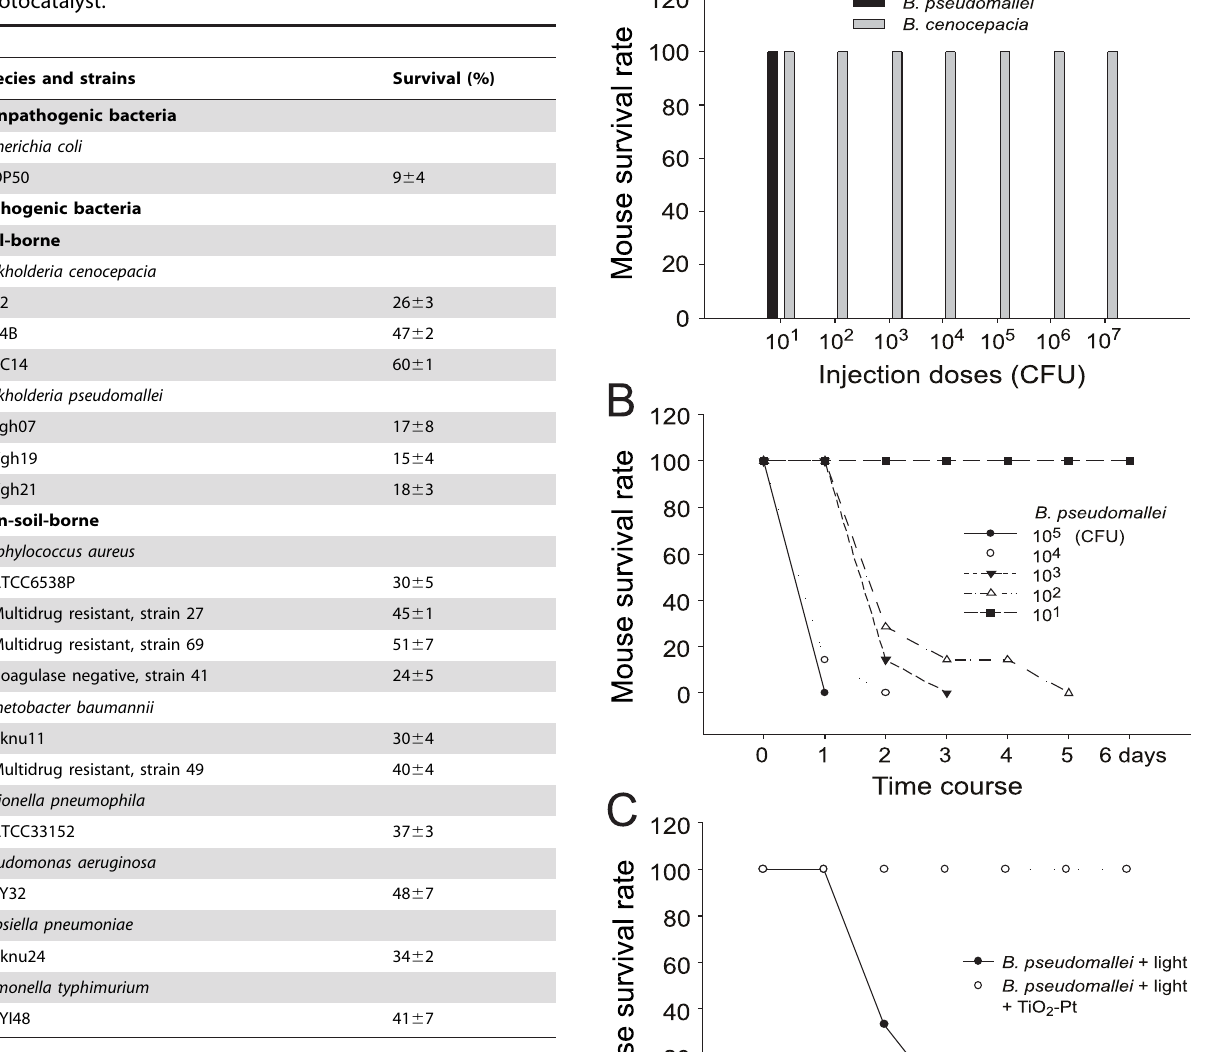
Table 1. The antibacterial spectrum of the nanoscale TiO 2 -Pt photocatalyst.